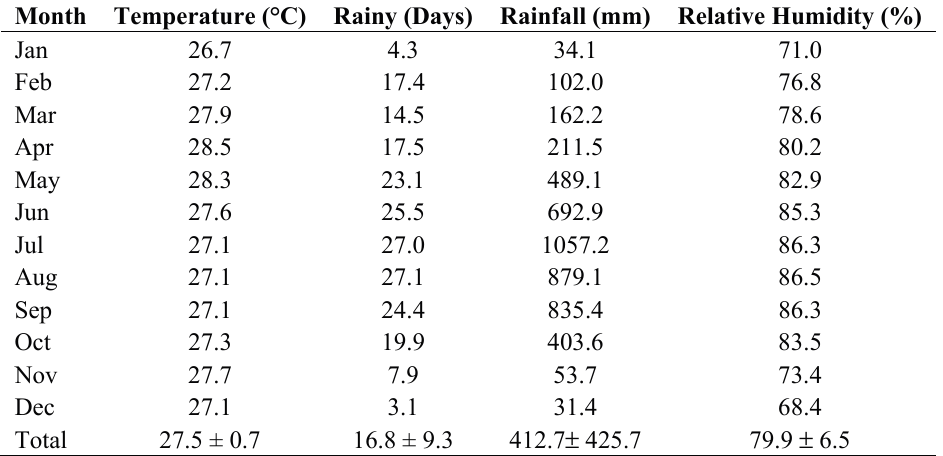
Table 1. Climate conditions classified by month and season on Koh Chang,